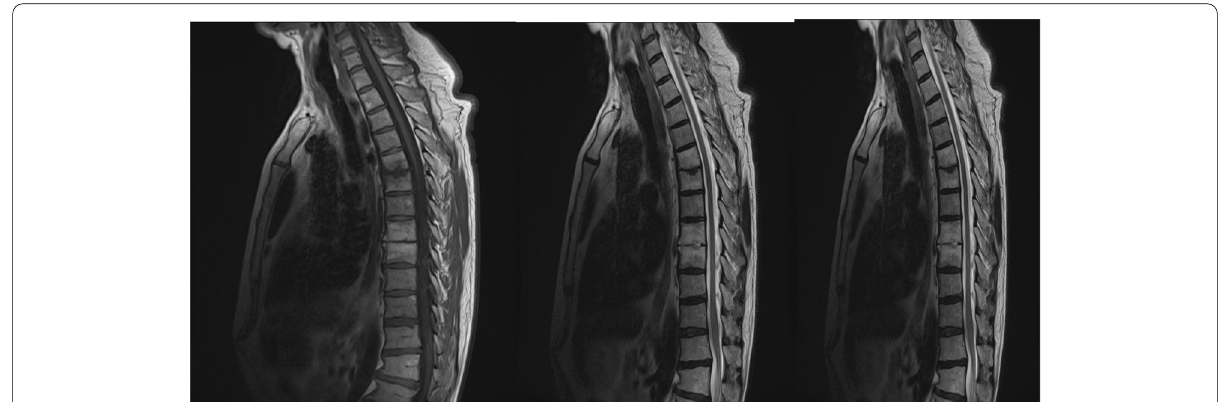
Fig. 5 MRI of the thoracolumbar spine showing the evolution under treatment of the T5–T6 and T8–T9 brucellar